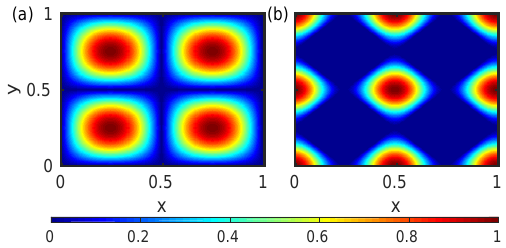
Figure 1. Colour-coded representation of the modulus of vortic- ity (a) and the Okubo–Weiss parameter (b) for the eddy field in Eq. (6). All plots are normalized to the maximum value.